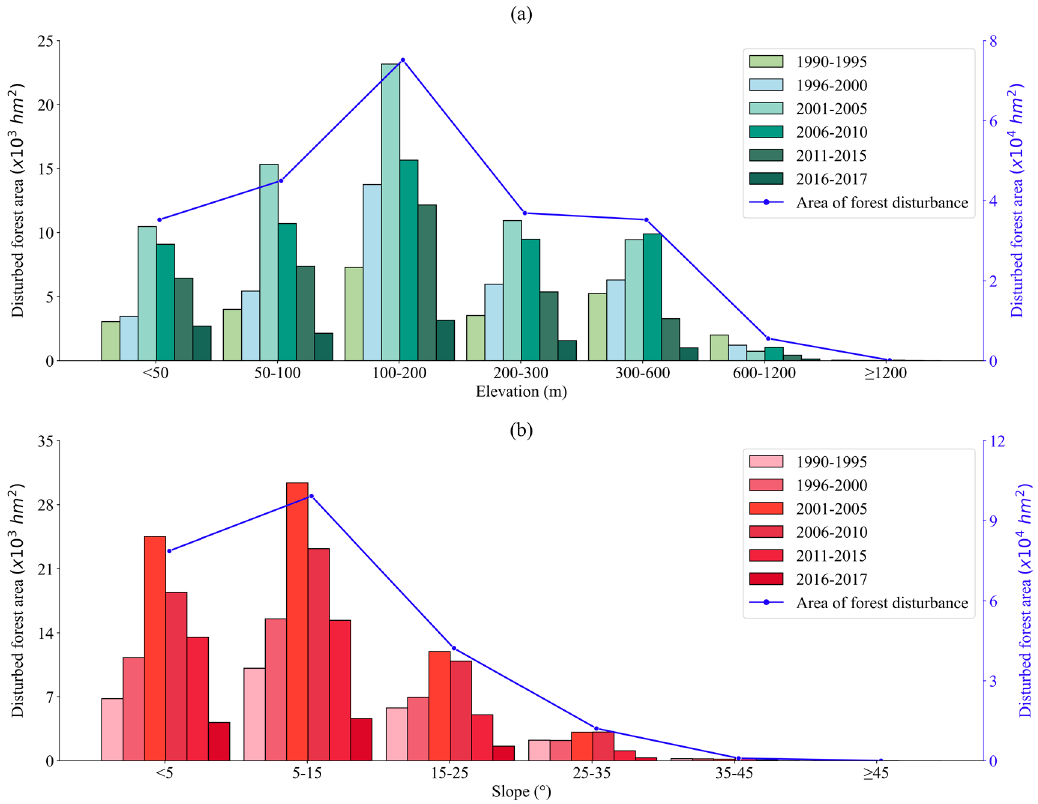
Figure 8. Areas of forest disturbance at different elevations and slopes on Hainan Island: ( a ) elevation and ( b ) slope.